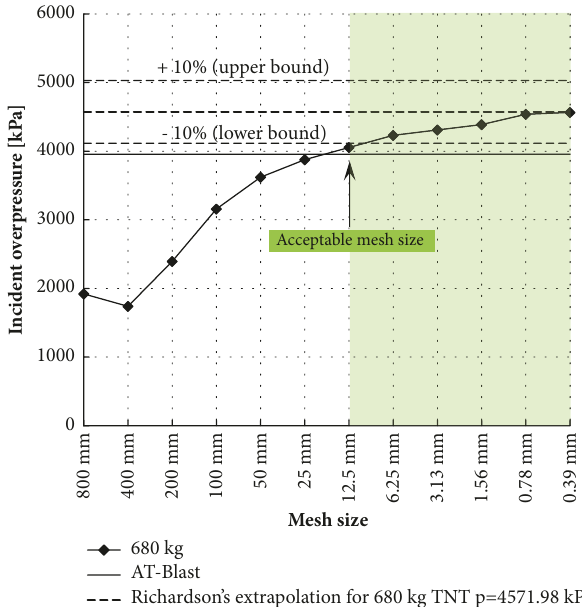
Figure 8: Determination of acceptable air mesh size for incident